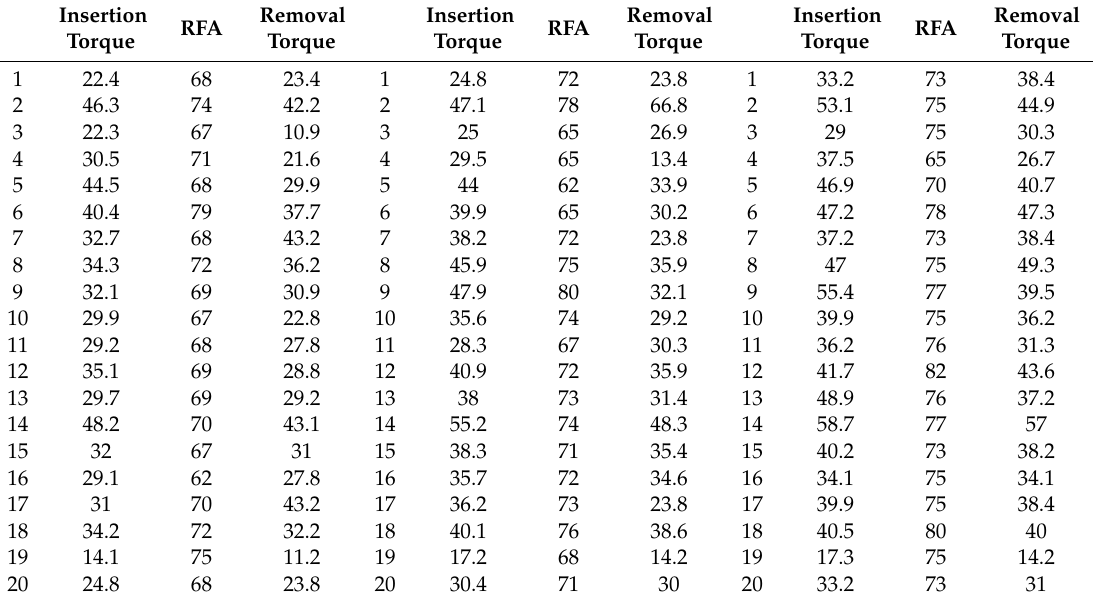
Table 1. Primary stability data of each group.